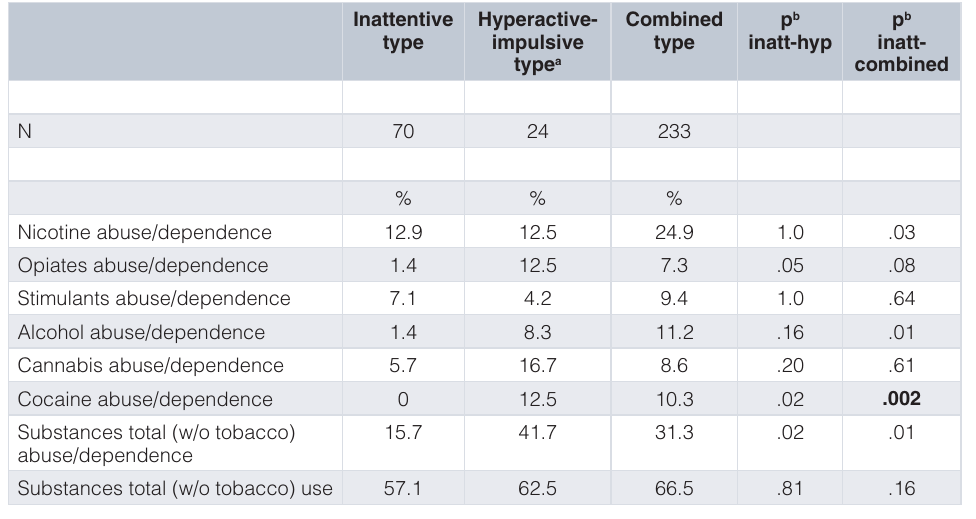
Table 1. Lifetime substance use by ADHD subtype (p-values surviving Bonferroni threshold [p ≤ .002] in